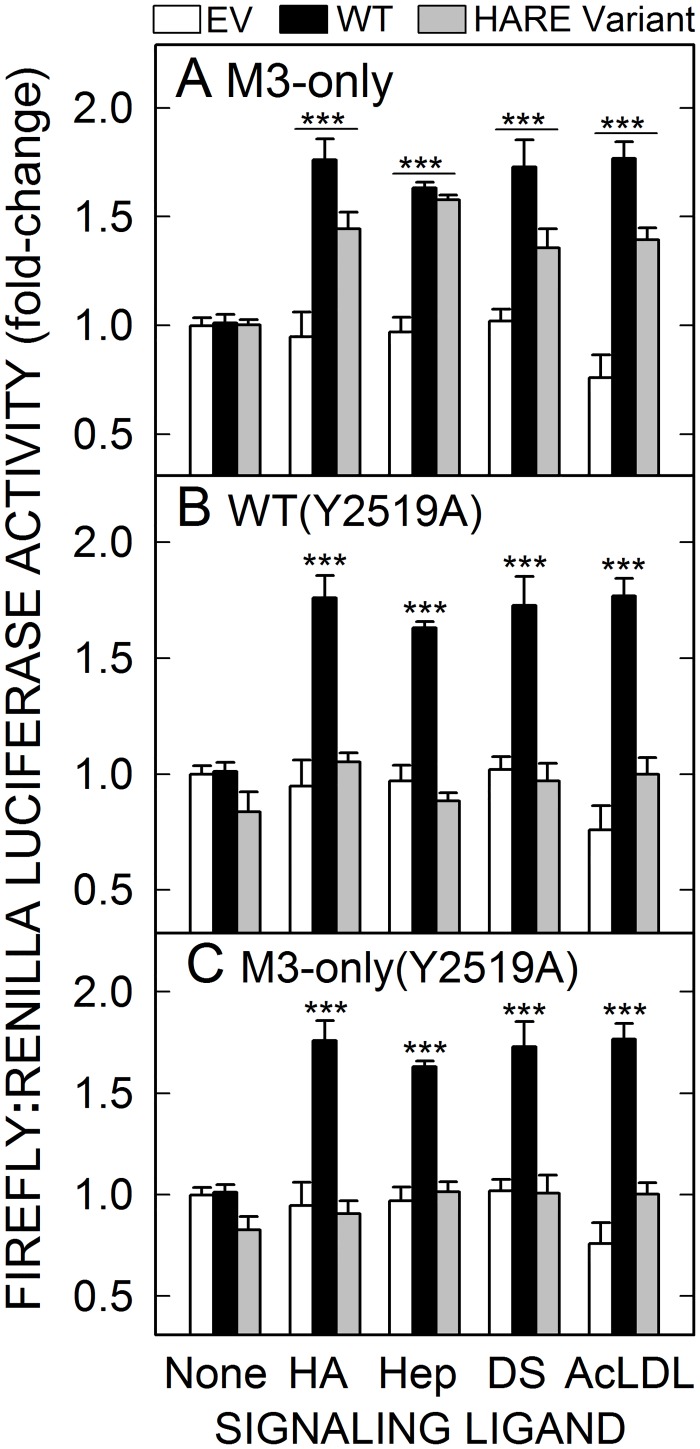
Tyr2519 in HARE M3 modulates NF-κB activation and gene expression in response to endocytosis of multiple ligands.Cells expressing EV (white bars), WT (black bars) or the indicated mutant (gray bars) HARE were grown, transfected, and incubated at 37°C for 4 h as in Fig 5 with 100 nM of one of the four signaling ligands: HA, Hep, DS or AcLDL. All cells were processed, and analyzed for relative LUC activity as in Fig 1: M3-only, (A); WT(Y2519A), (B); or M3-only(Y2519A), (C). Values are means ± SEM (n = 9) of the indicated ratio of the two LUC enzymes from three independent experiments, with the value of mock-treated cells as 1.0. Values for p are based on one-way ANOVA and pair-wise Tukey’s tests using pairwise comparisons of HARE WT or mutant cells with EV cells for each ligand: ***, p < 0.001.